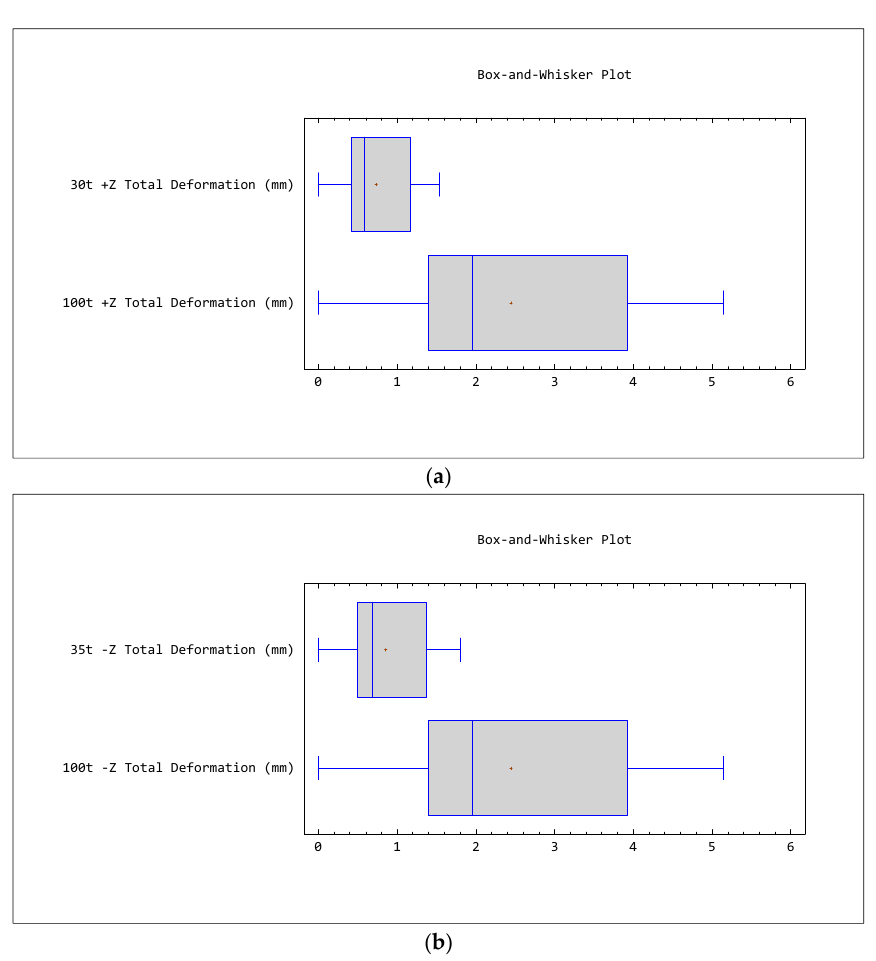
Figure 9. ( a ) Lifting: +Z total deformation and ( b ) stacking: − Z total deformation.